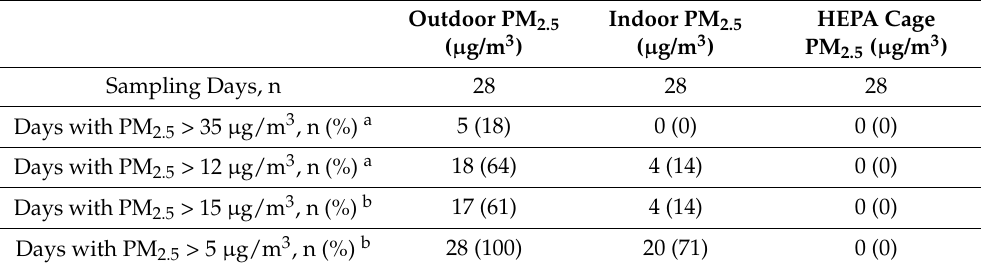
Figure 3. Time series plot for fine particulate matter across three sampling locations. PM 2.5 = fine particulate matter. Horizontal lines indicate PM 2.5 thresholds: United State Environmental Protection Agency–24-h standard of 35 µg/m 3 (solid line) and annual mean of 12 µg/m 3 (long dashes); World Health Organization–24-h guideline of 15 µg/m 3 (short dashes) and annual mean of 5 µg/m 3 (alternating short/long dashes). Table 3. Number of days that sensor measurements surpassed EPA and WHO thresholds .